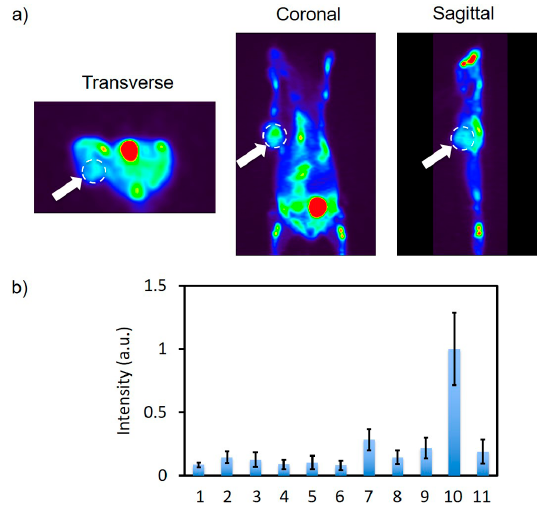
Figure 8. ( a ) Tomographic PET imaging of a flank A549 tumor 6 h after intravenously injecting the Cy5-BF 3 ( 18 F). The white dashed circles indicate the tumor; the brightest spot (red) is the bladder, indicating renal clearance of the probe ( b ) the quantitative biodistribution by gamma counter (Wallac Wizard 3.0, %ID normalized to tumor) 6 h after intravenously injecting Cy5-BF 3 ( 18 F). The data are normalized on the tumor. 1—Heart, 2—Liver, 3—Spleen, 4—Lung, 5—Kidney, 6—Stomach, 7—Intestine, 8—Bone, 9—Muscle, 10—Tumor, 11—Brain.